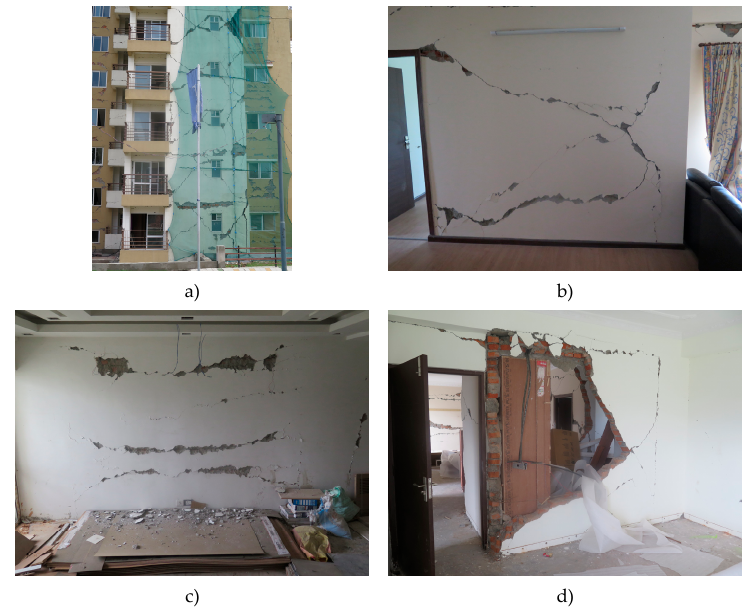
Figure 5. Survey damage assessment of the building: a ) north façade; b ) south-east façade.